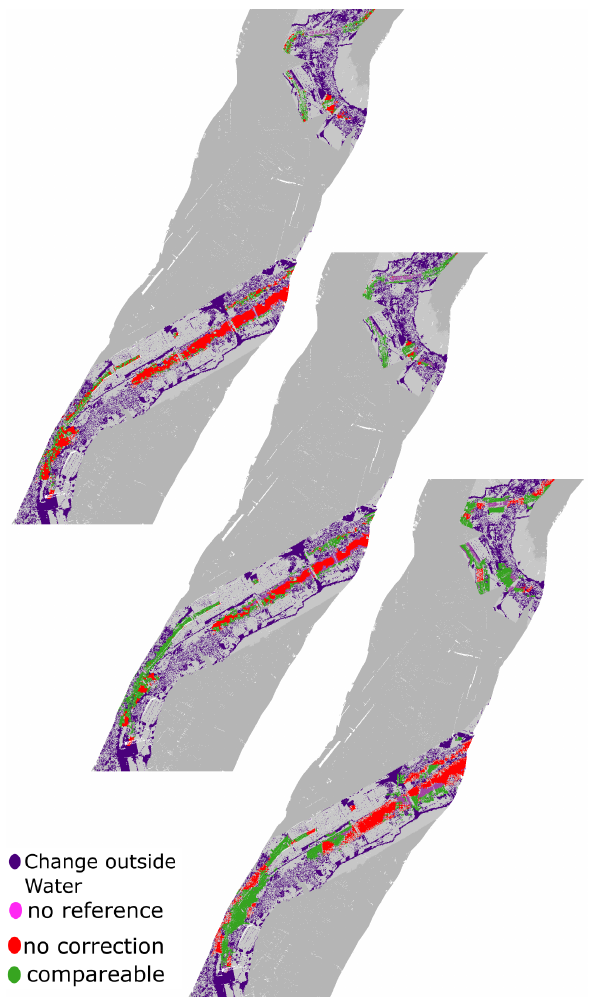
Figure 9. Result for assigning change labels. Shown are the results of different voxel sizes, from top to down: 0.5 m, 1 m, 4